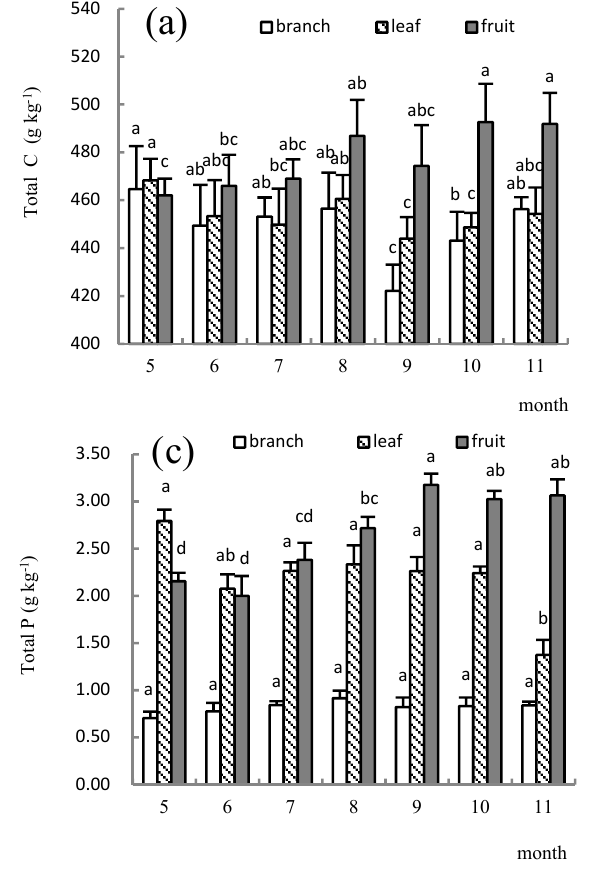
Figure 1. Monthly dynamic of C ( a ), N ( b ), P ( c ) contents in different organs of female plants of F. velutina . Note: Means of different months not sharing the same letter indicated significant differences at an alpha level of 0.05, according to an LSD test.